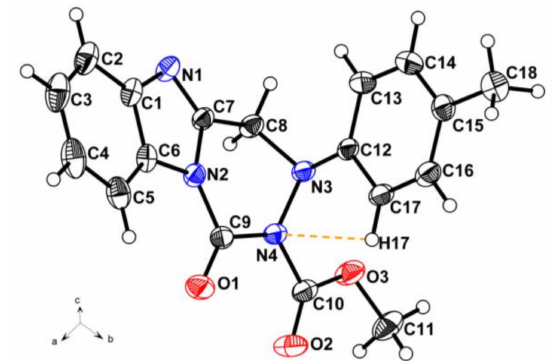
Figure 2. Crystal structure diagram of compound 4n with intramolecular hydrogen bond.